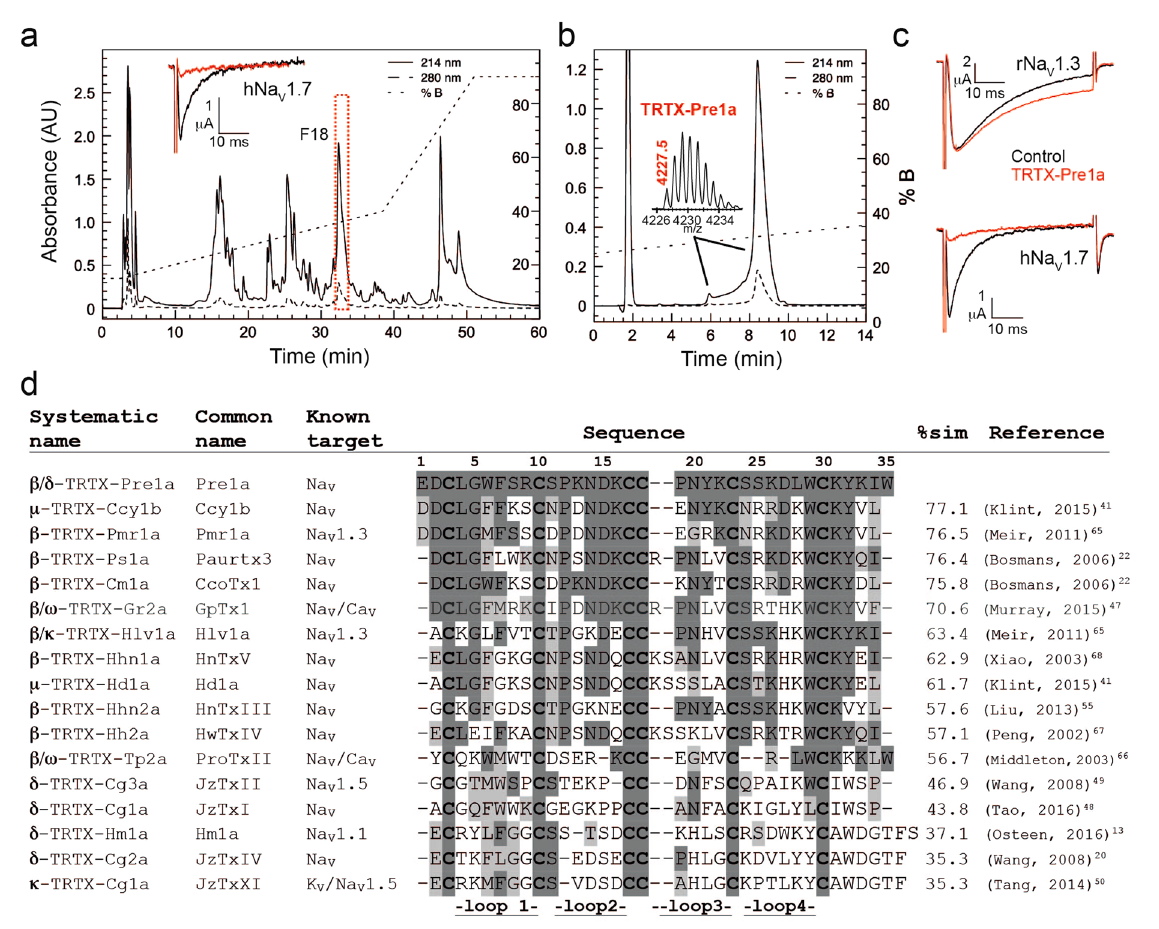
Figure 1. Identification and sequence of TRTX-Pre1a. ( a) RP-HPLC chromatogram of crude venom from P. reduncus indicating the fraction (F18) responsible for robust inhibition of hNa V 1.7 expressed in Xenopus oocytes (inset). ( b) Final analytical RP-HPLC purification step of F18 (TRTX-Pre1a) (inset: MALDI-TOF MS spectrum showing M + H + of 4227.5). ( c) Activity of pure, native Pre1a on rNa V 1.3 and hNa V 1.7 exressed in Xenopus oocytes demonstrating inhibition of inactivation and peak current, respectively. ( d) Sequence alignment of TRTX-Pre1a with Na V modulating Theraphotoxins 13, 20, 22, 41, 47–50, 55, 65–68 . Percent similarity was calculated comparing the number of identical (dark gray) and similar (light gray) amino acids.